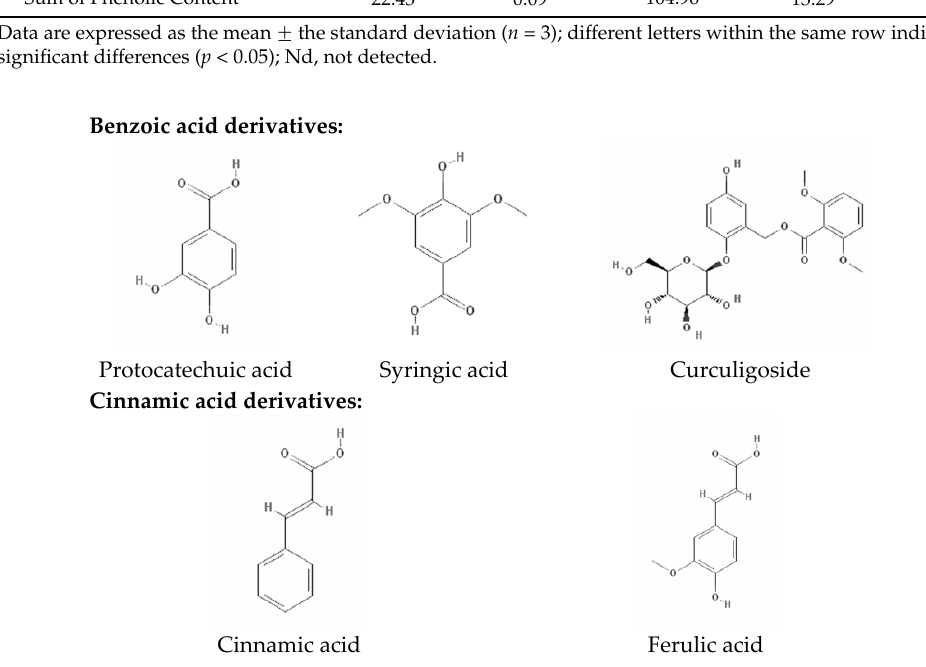
Table 3. Antioxidant activities of M. latifolia rhizome methanolic extract and its fractions.